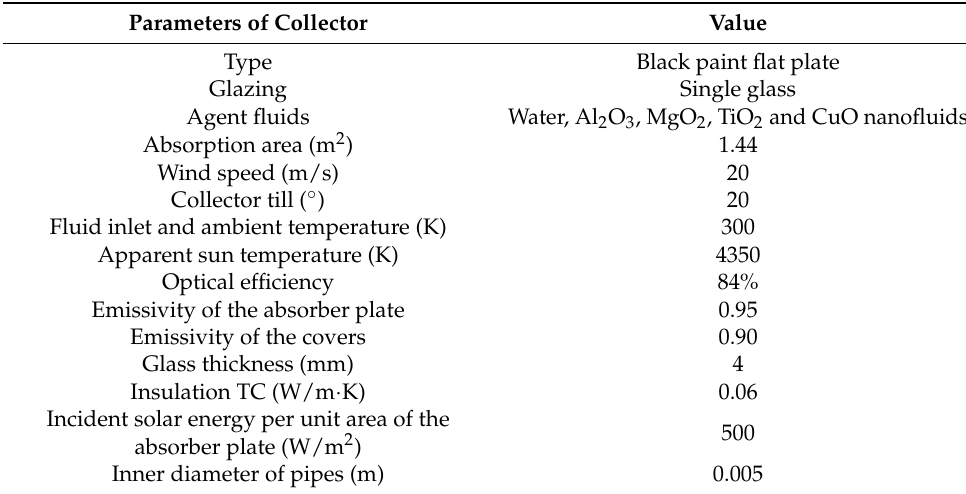
Table 4. Environmental and analysis conditions for the